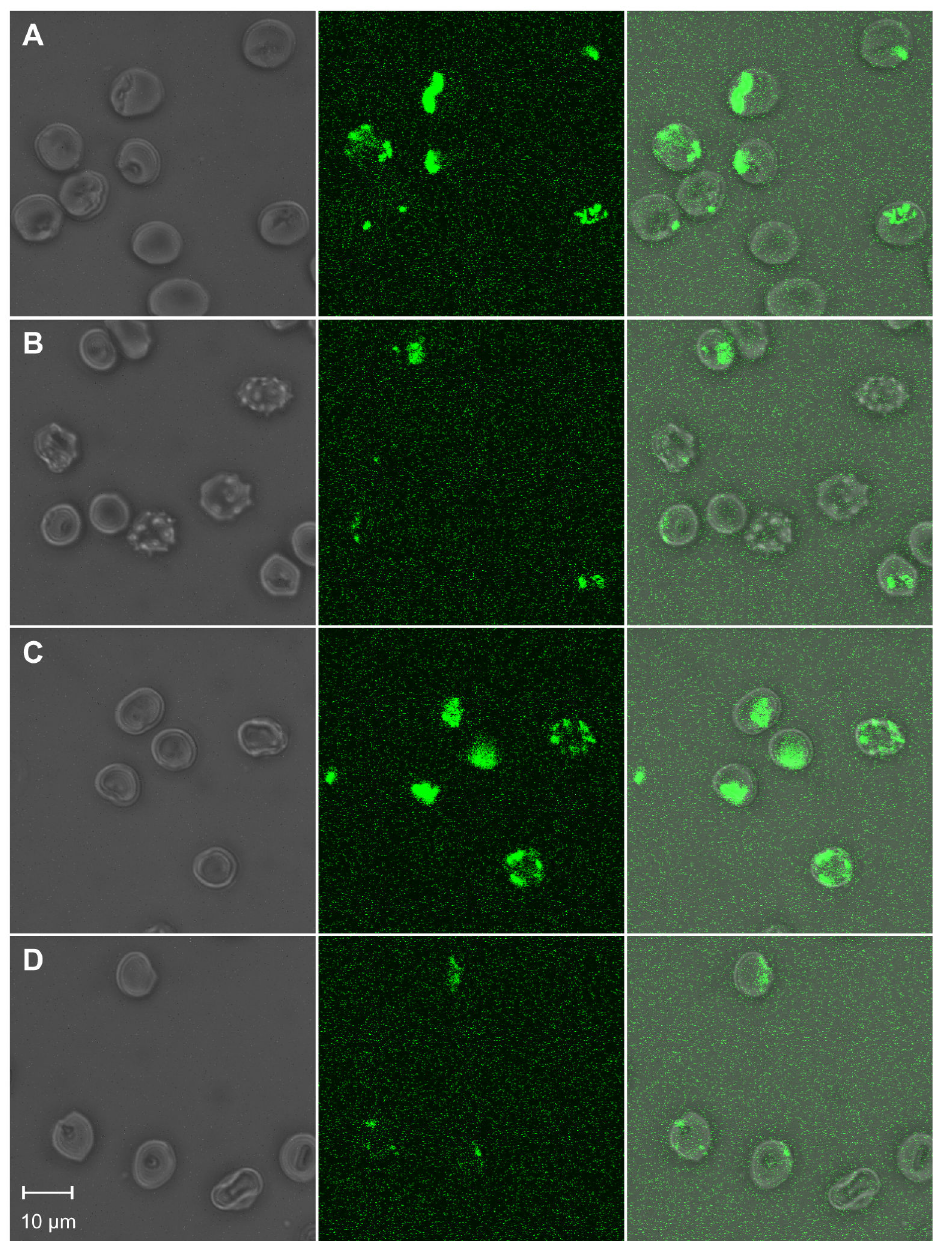
Figure 1. Microscopic comparison of patient’s and control erythrocytes in drug-induced endovesiculation. Erythrocytes of a PKAN+ patient (B and D) and a control donor (A and C) were treated with 3 mM primaquine (A and B) or 0.8 mM chlorpromazine (C and D) in the presence of FITC-dextran to monitor the formation of endovesicles by confocal microscopy. Representative phase contrast (left panels), fluorescence (middle panels) and overlay (right panels) images are shown.